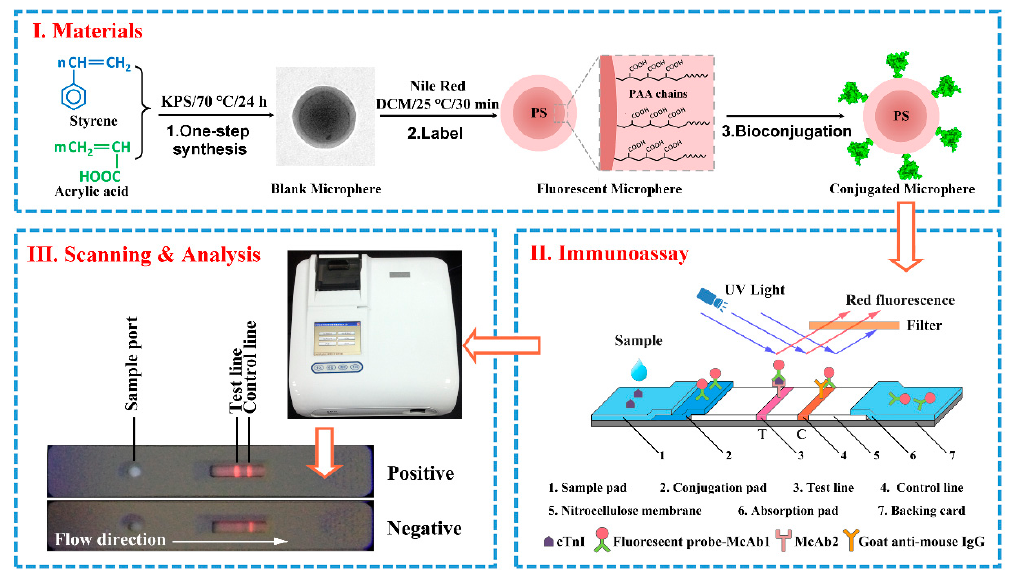
Figure 1. The schematic representation of ( I ) The synthesis of fluorescent immune-microspheres; ( II ) Immunoassay mechanism lateral flow test strip and ( III ) Scanning & analysis process.